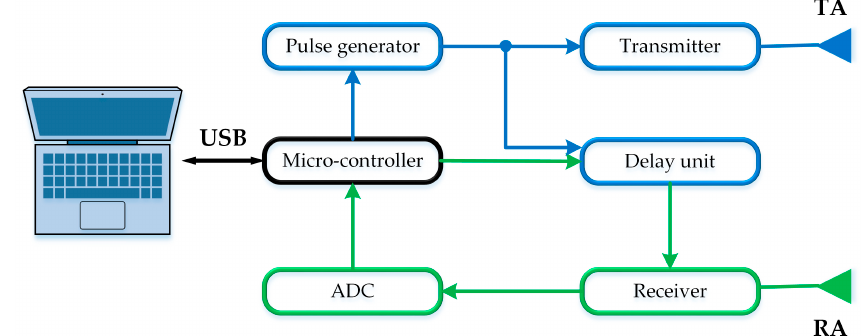
Figure 1. Block diagram of ultra-wideband (UWB) radar. Abbreviations: ADC, Analog-to-Digital Converter; TA, transmitter antenna; RA, receiving antenna. Table 1. Key parameters of the UWB radar.